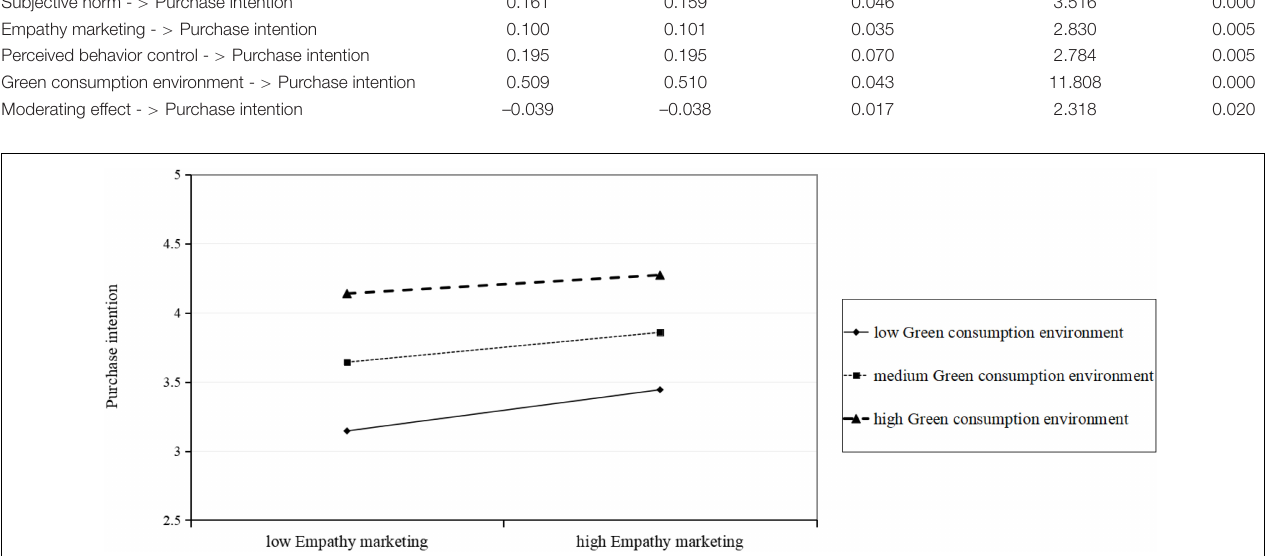
FIGURE 4 | Moderating effect analysis of the model.